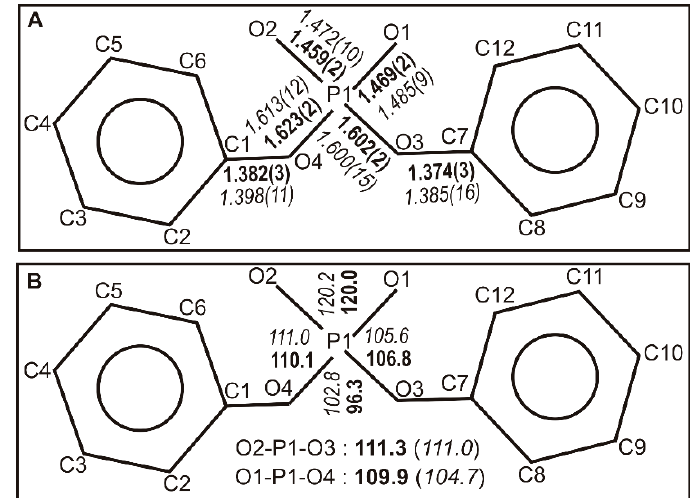
Figure 7. Structural comparison of the anion moiety, diphenyl phosphate, of the title compound. ( A ) Bond lengths of the diphenyl phosphate moiety, except for two phenyl rings, are shown and compared with the literature values extracted from the CSD. ( B ) Selected bond angles of the anion moiety of the title compound are marked with the literature values. The bond lengths and angles of the title compound are shown in boldface and the average bond lengths, and bond angles calculated from the 12 model structures extracted from the CSD, are shown in normal italic.